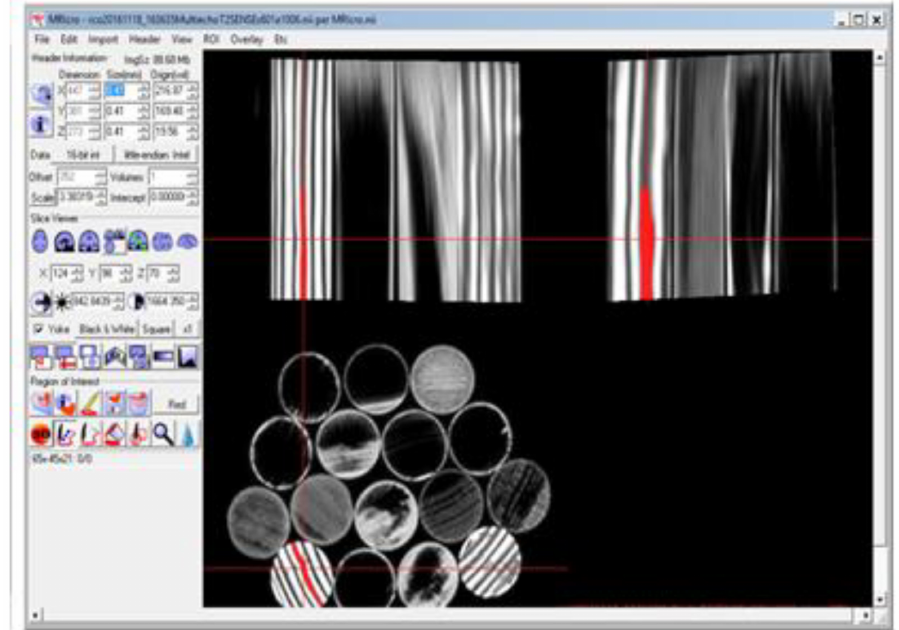
Figure 7. Screen capture image of the sample constituted of 16 different wood cylinders partially imbibed with water. Using MRIcro software it is possible to observe the volume of the sample along the three views: longitudinal, sagittal, and axial (transversal). This modality may be useful to follow and monitor the water the entry of water into the wooden structures, as highlighted in red in the images at different views. The mean cross-section diameter of wood samples is 2.95 ± 0.05 cm, and it is 20.0 ± 0.1 cm